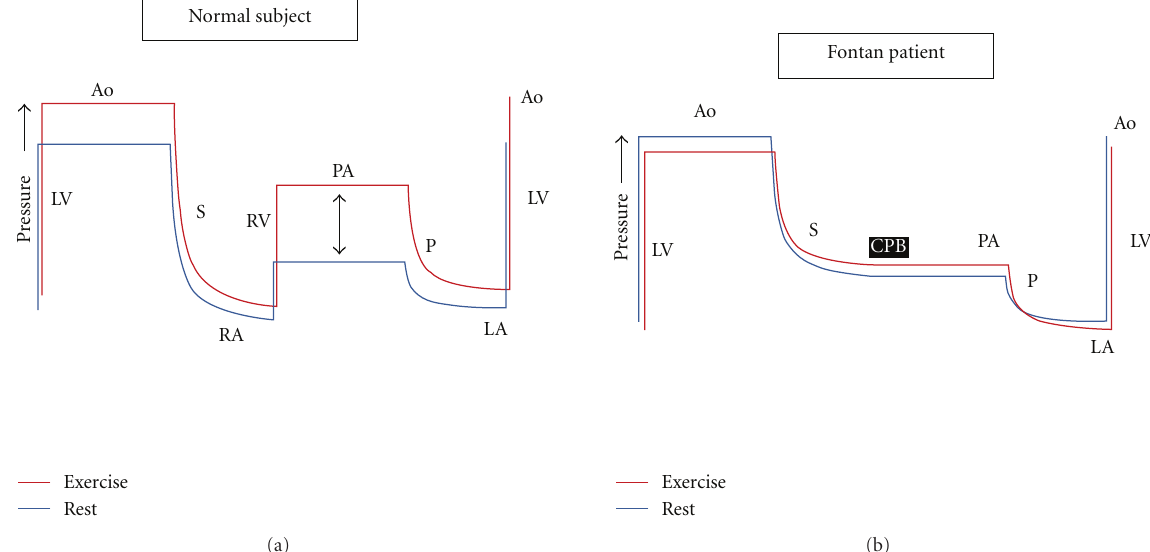
Figure 1: Theoretical schema to illustrate circulatory pressure changes in normal and Fontan patients at rest and during exercise. In the normal circulation, pressure is generated in the systemic ventricle (LV) to produce flow in the aorta (Ao) and systemic circulation (S). Pressure dissipates across the systemic microcirculation such that right atrial (RA) pressures are low. The pre-pulmonary pump (RV) provides the pressure to generate the flow in the pulmonary artery (PA) which then dissipates in the pulmonary circulation (P) but is su ffi cient to maintain preload in the left atrium (LA). During exercise, systemic vascular resistance falls such that there is little increase in mean LV pressure requirements. However, more substantial pressure increases are required in the RV (purple arrow), and these pressure requirements increase with exercise intensity. In the Fontan patient (below), the cavopulmonary bypass (CPB) does not provide any contractile force and, therefore, flow through the pulmonary circulation is dependent on the pressure di ff erence between the RA and LA. During exercise, trans-pulmonary flow can only be augmented by reductions in pulmonary vascular resistance. Beyond mild to moderate exercise, pulmonary vasodilation is maximal and flow increases require a pre-pulmonary pump. Without this, pulmonary pressure does not rise, trans-pulmonary flow does not increase, LA pressure (preload) does not increase, and cardiac output cannot supply the metabolic demands of